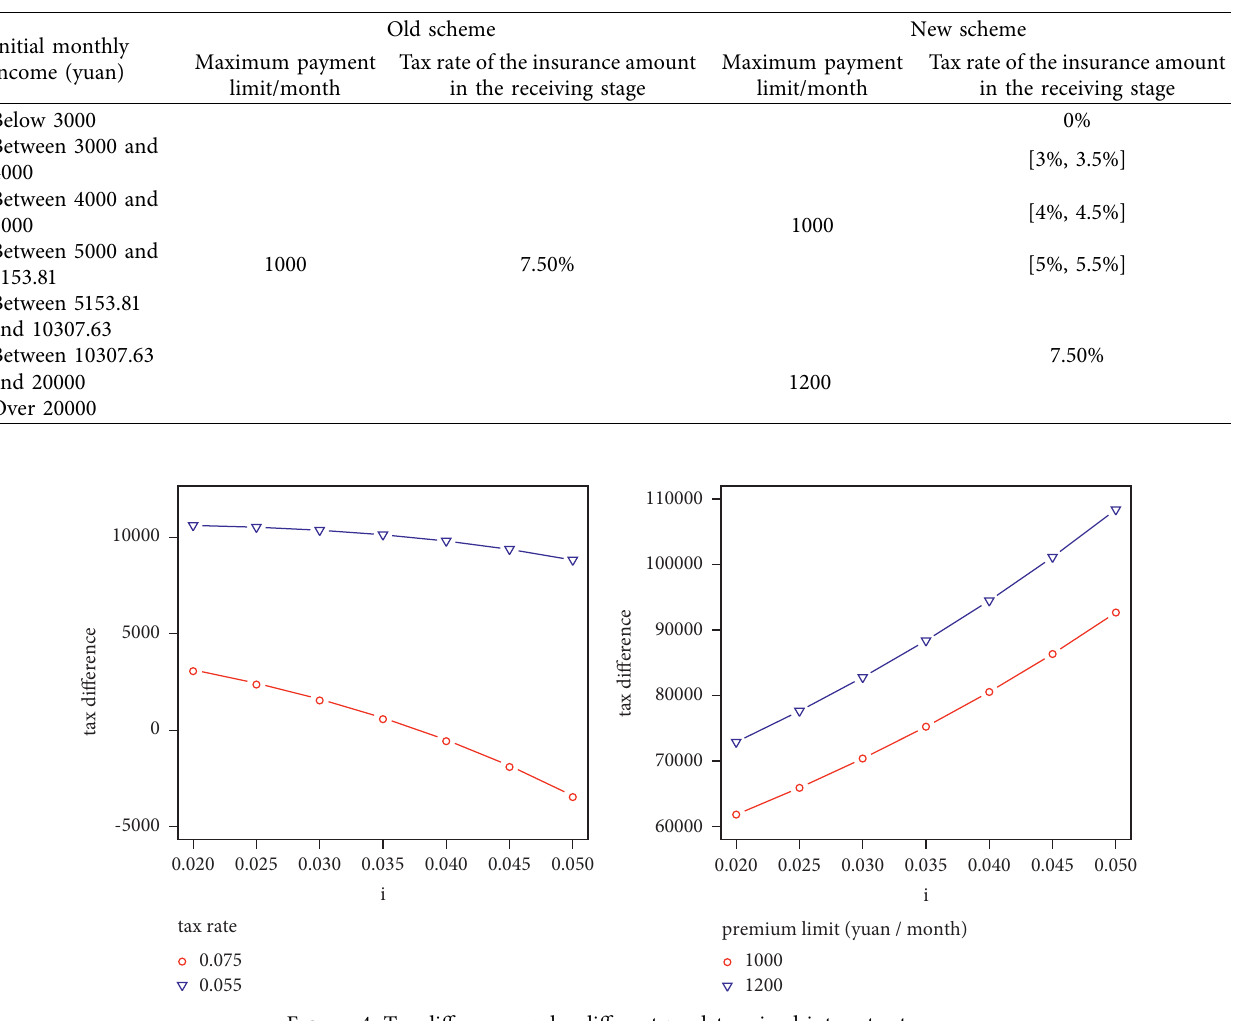
Table 6: The new and old optimization scheme of the IITDCEI.